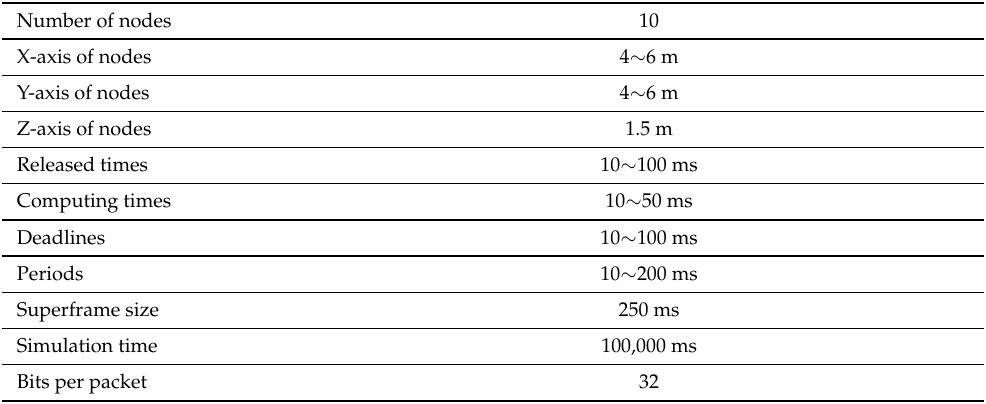
Table 5. Scheduling parameters.